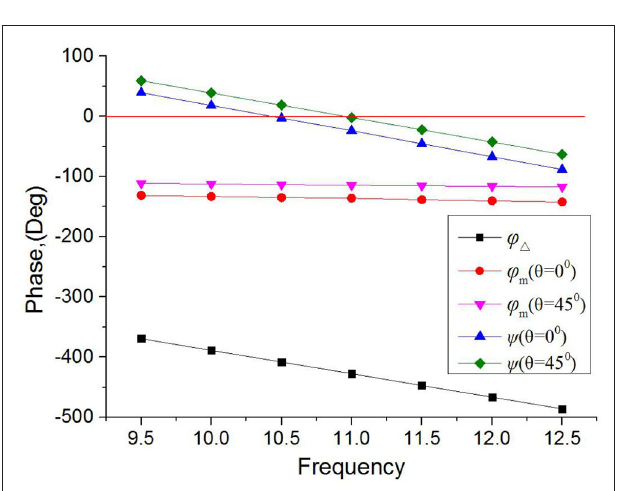
FIGURE 5 | The path difference ϕ 1 , the reflection phase ϕ m of the metasurface and the total phase difference Ψ at different